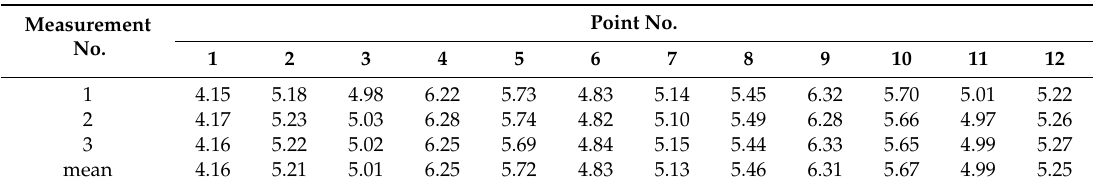
Table 1. Wall thickness measurement values of the trailing arms.